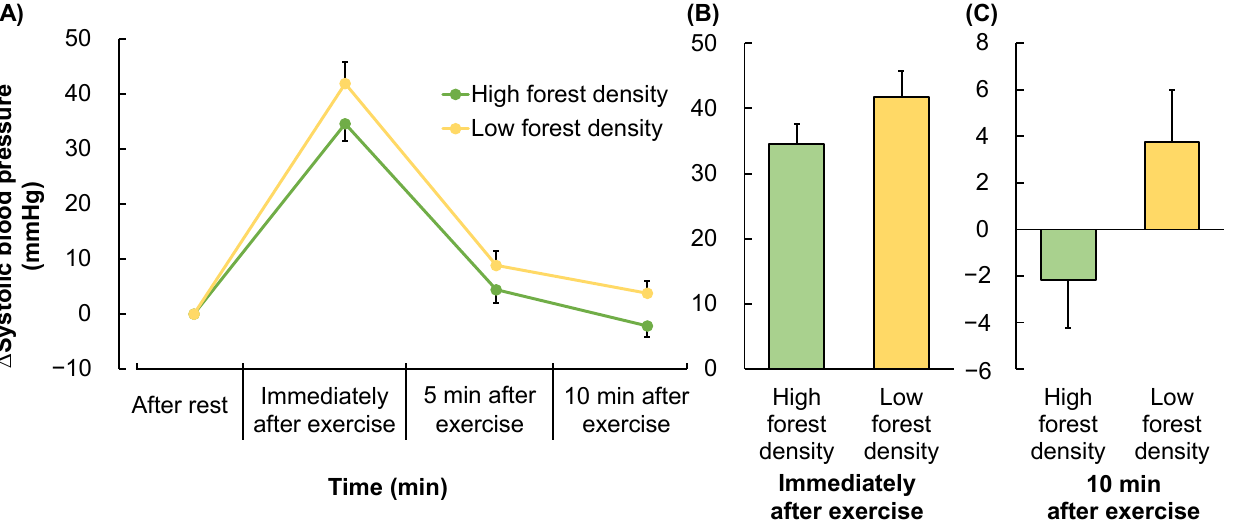
Figure 9. Average systolic blood pressure of blood pressure between high forest density and low forest density. ( A ) Changes in four periods on average systolic blood pressure frequency. N = 17, mean ± standard error. ( B ) Effect on systolic blood pressure frequency in “immediately after exercise”. N = 17, mean ± standard error. * p < 0.05 using the paired t ‐ test. ( C ) Effect on systolic blood pressure frequency “10 min after exercise” N = 17, mean ± standard error. * p < 0.05 using the paired t ‐ test.